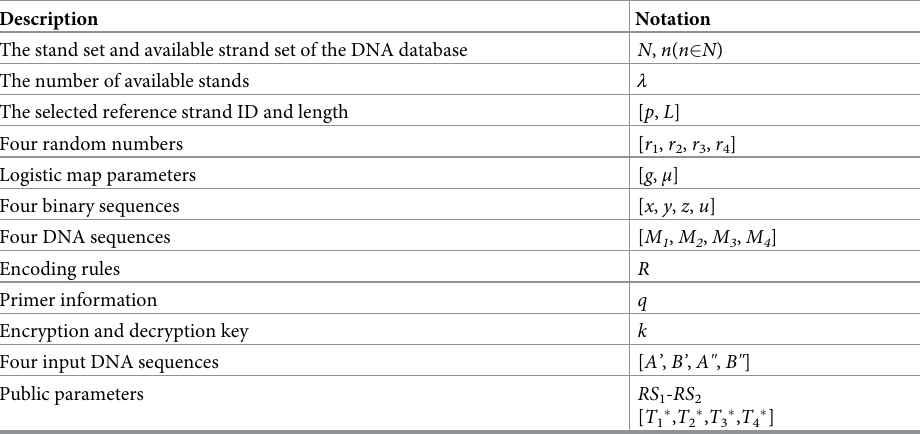
Table 1. Parameter definition.